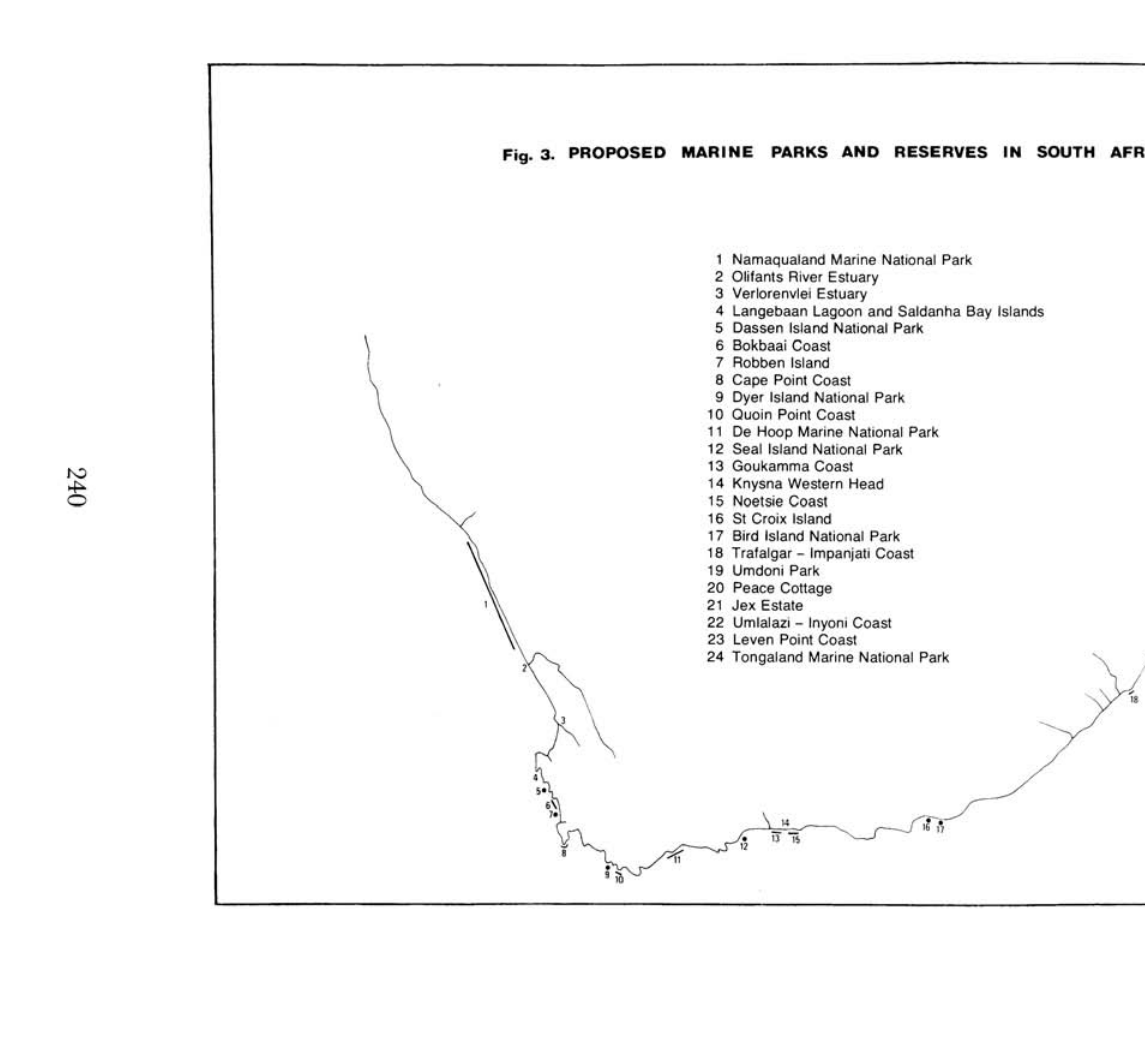
Fig. 3. PROPOSED MARINE PARKS AND RESERVES IN SOUTH